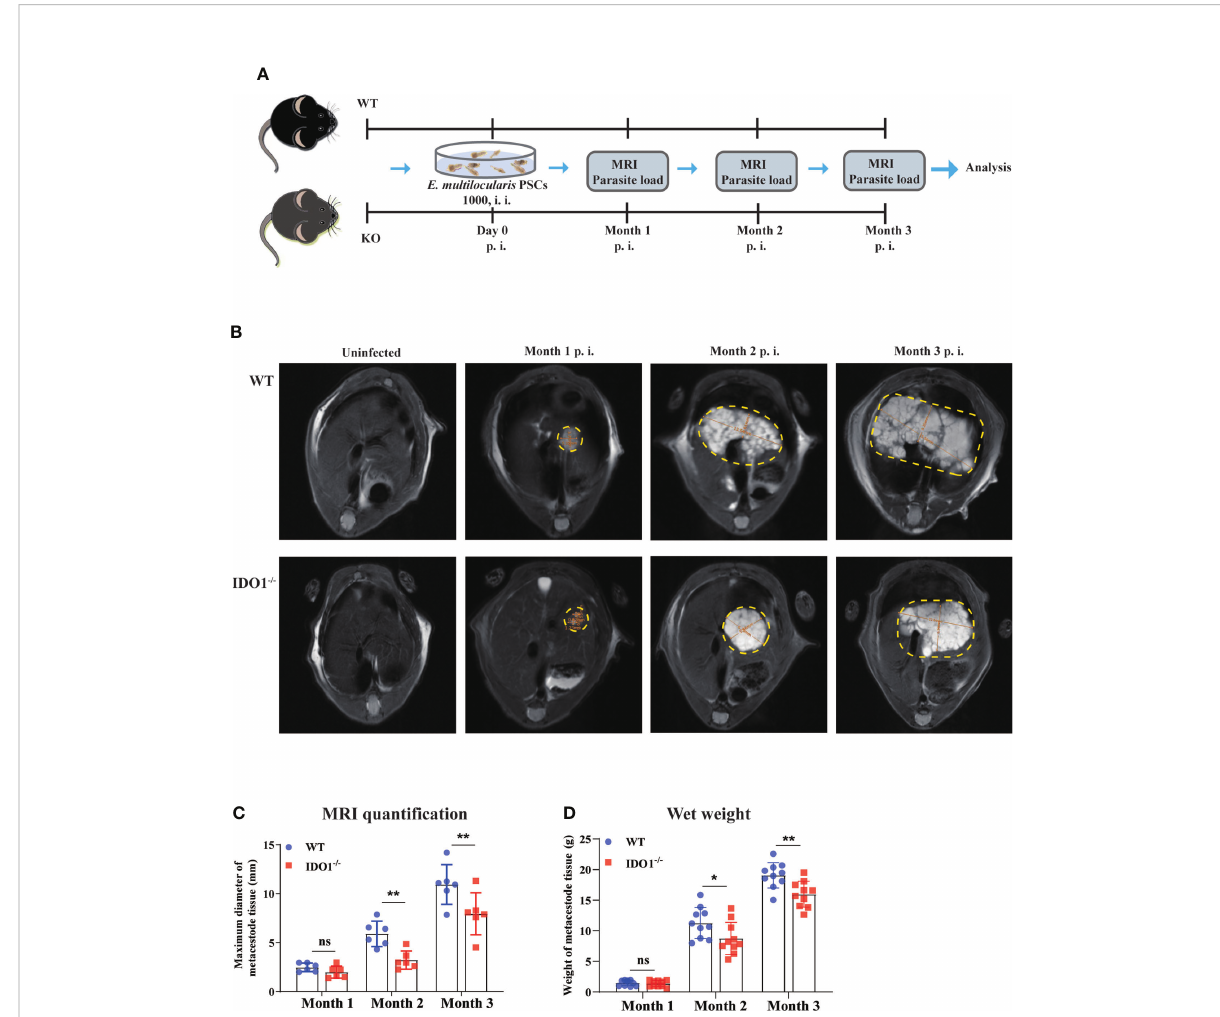
FIGURE 2 The effects of IDO1 on lesion area and parasite load in E multilocularis infected mice. (A) Schematic representation of the experimental setup. (B) Representative MRI images of metacestode tissue in the liver of IDO1 -/- and wild-type (WT) mice infected with E multilocularis , and metacestode tissues are manually encircled with dashed yellow lines. (C) The maximum diameter of metacestode tissues in IDO1 -/- and WT mice was quanti fi ed during MRI scanning using software in month 1, 2 and 3 post-infection with E multilocularis (n = 6/group). (D) The parasite load in IDO1 -/- and WT mice assessed by wet weight measurement at 1-, 2, and 3- month post-infection with E multilocularis (n = 10/group). Data are pooled from 2 independent experiments, and presented as the mean ± SEM. ns, not signi fi cant; *, p< 0.05; **, p< 0.01. PSCs, protoscoleces; p.i., post infection; i.i., injected intraperitoneally; MRI, magnetic resonance